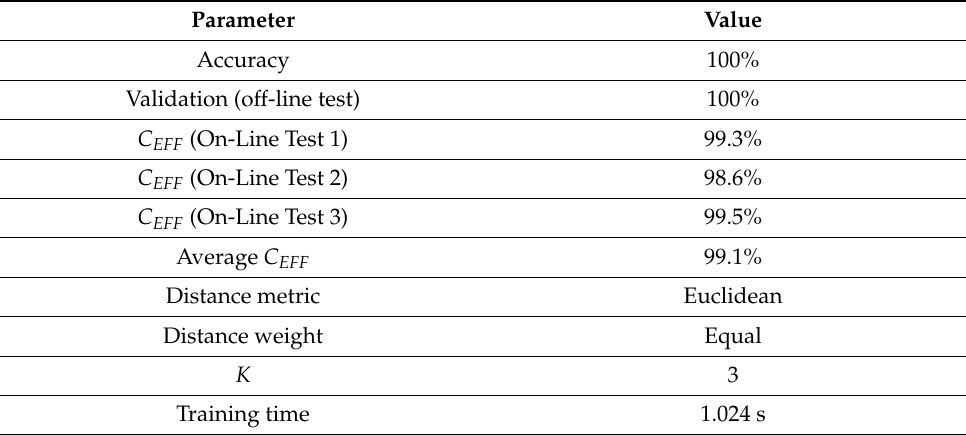
Table 5. Parameters of the proposed KNN classifier